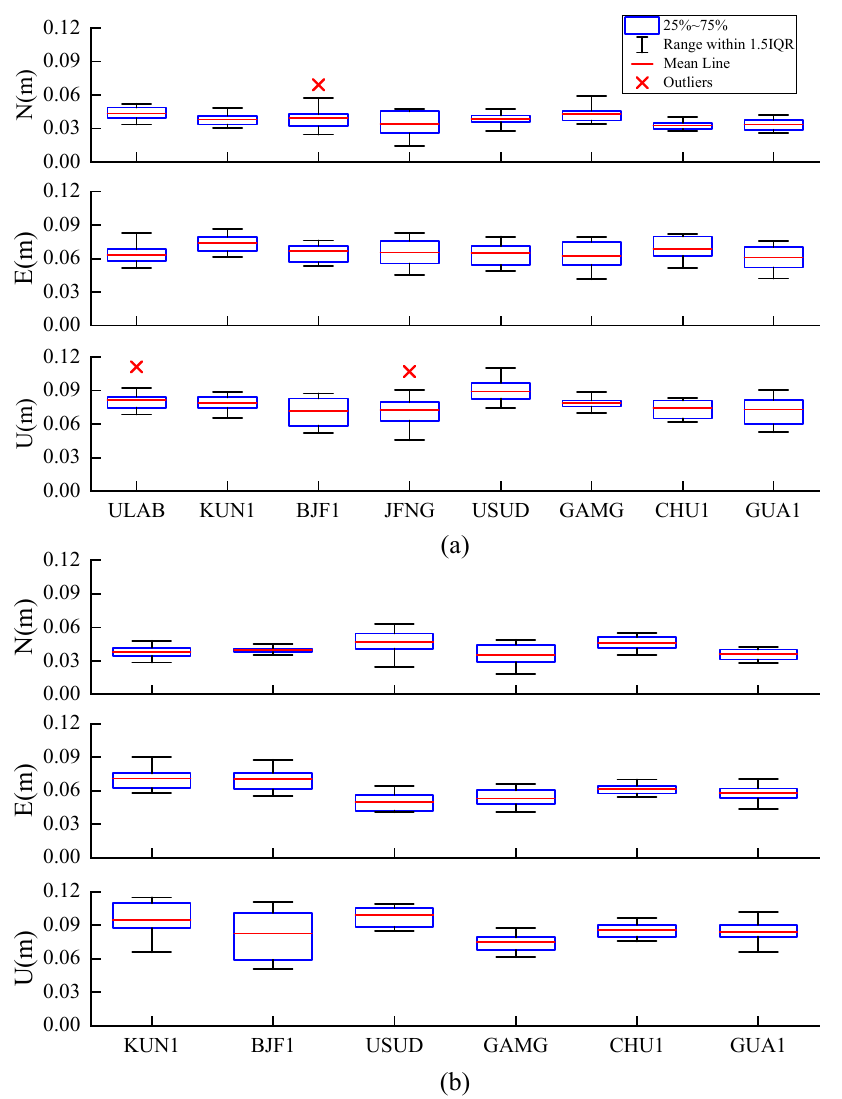
Figure 11. ( a ) PPP-B2b position error RMS values using BDS B1I/B3I in the simulated kinematic mode; ( b ) PPP-B2b position error RMS values using BDS B1C/B2a in the simulated kinematic mode. Table 8. Mean RMS values of PPP-B2b kinematic positioning at each station using B1I/B3I.